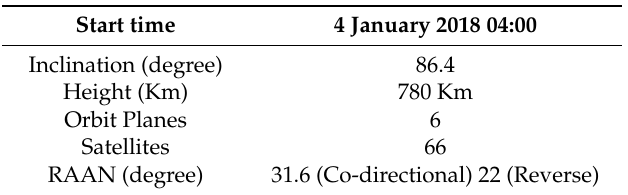
Table 2. Orbital parameters in satellite